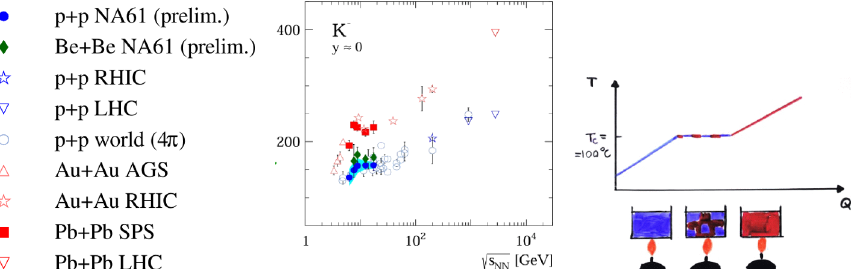
Figure 3. The step is clearly visible for Pb + Pb collisions, but also seen in p + p collisions, as well as in Be + Be collisions which are close to p + p ( left). The step-e ff ect can be seen as an analogue to the temperature step for heating of water beyond the boiling point (